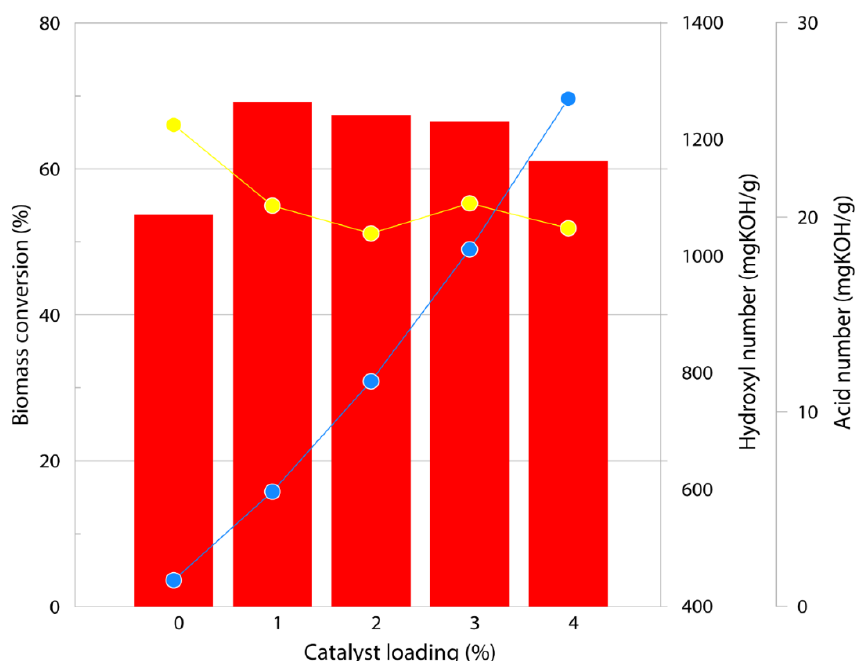
Figure 4. Effect of catalyst loading on biomass conversion and biopolyol acid number (blue line) and hydroxyl number (yellow line). Reaction condition: solvent blending ratio, 1:2; temperature, 120 °C; biomass loading, 20%; reaction time, 10 min.